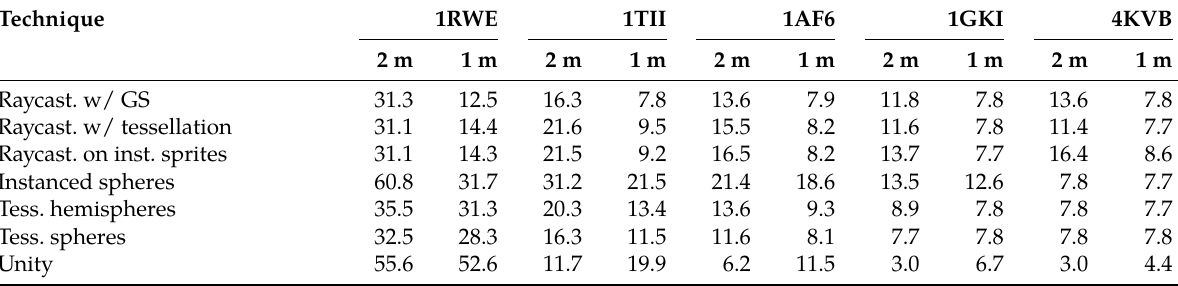
Table 3: Comparison of average frame rates for the rotation around the y-axis between the UWP and the Unity prototype. Technique 1RWE